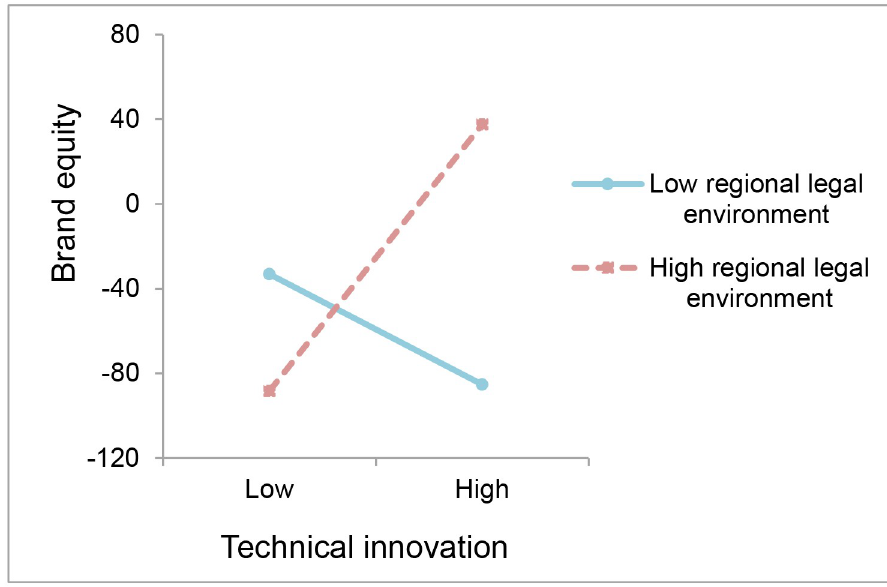
Fig 2. The moderating effects of H 4a